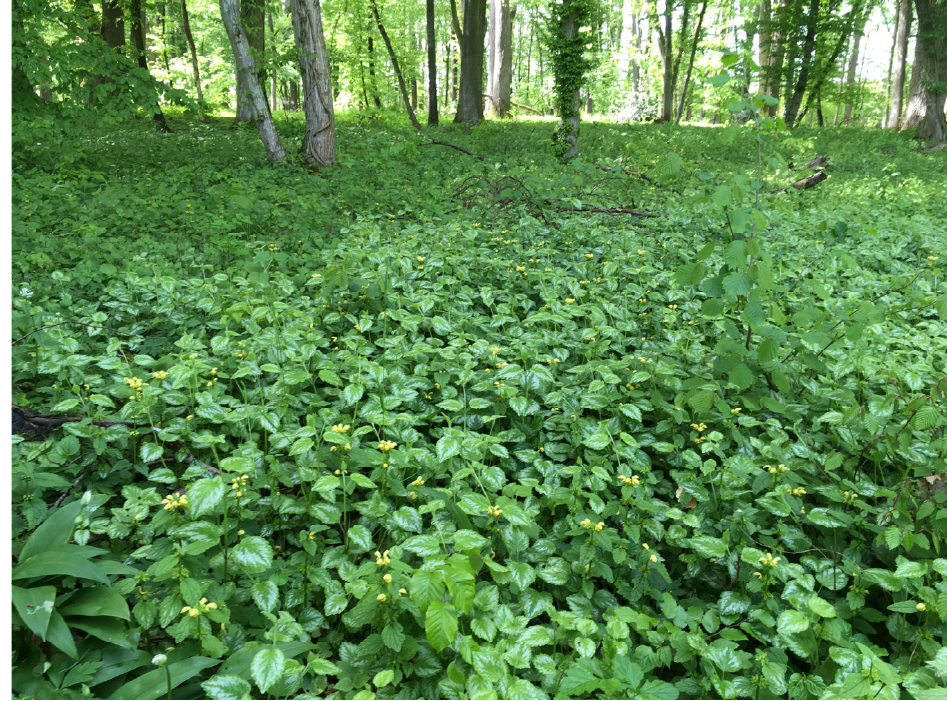
Figure 2. Patch of Lamium galeobdolon subsp. argentatum in the forest of Allschwil near Basel, Switzerland. Photo: K. Huber.